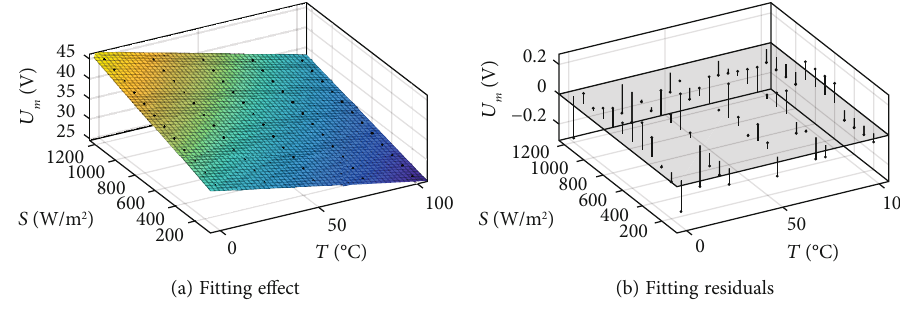
Figure 8: Curve fi tting with Equation (9).